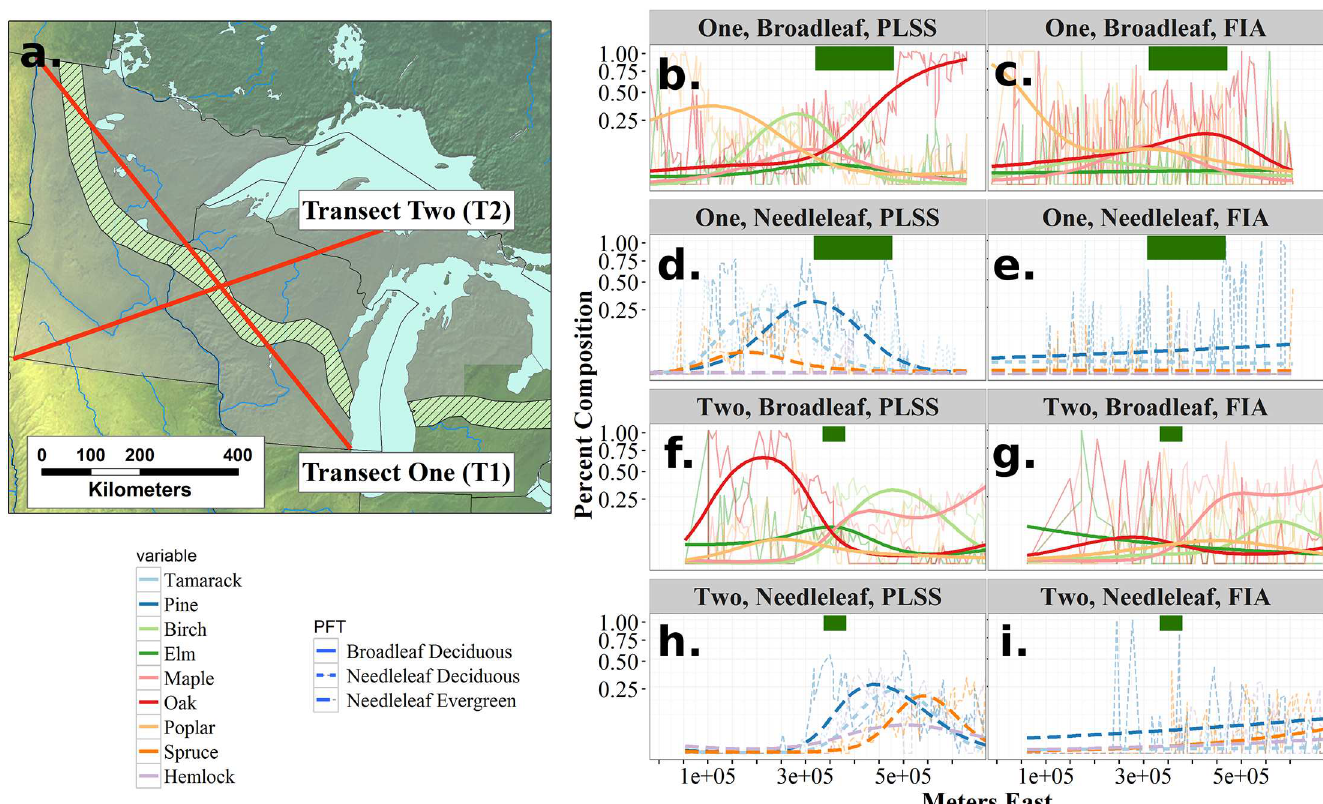
Fig 10. Transects(a) across the region show clear changes in the ecotonal strength. Transect One shows shifts in broadleavedtaxon distributions from the PLSS to FIA (b and c) and in needleleaved distributions(d and e). Transect Two broadleaf(f and g) and needleleaf(h and i) taxa show shifts that again appearto represent regionalscale homogenization. Ecotones in the pre-settlement era were strongerin the past than they are in the present. Fitted curves represent smoothedestimates across the transects using Generalized AdditiveModels using a beta